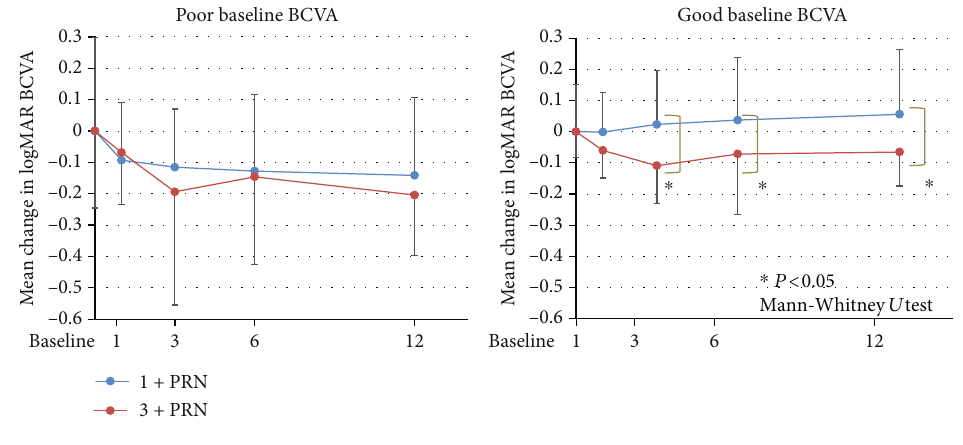
Figure 5: Comparisons of changes in BCVA (logMAR units) from the baseline in the poor baseline BCVA and the good baseline BCVA groups. In eyes with poor baseline BCVA, there was no signi fi cant di ff erence in the mean BCVA between the two groups at 12 months after the IVA. However, in eyes with the good baseline BCVA, the mean BCVAs in the 3+PRN group at 3, 6, and 12 months after the IVA were signi fi cantly improved compared to those in the 1+PRN group ( P = 0 : 0113 , P = 0 : 0164 , and P = 0 : 044 , respectively; Mann-Whitney U test). BCVA: best-corrected visual acuity; logMAR: logarithm of the minimum angle of resolution: PRN: pro re nata .